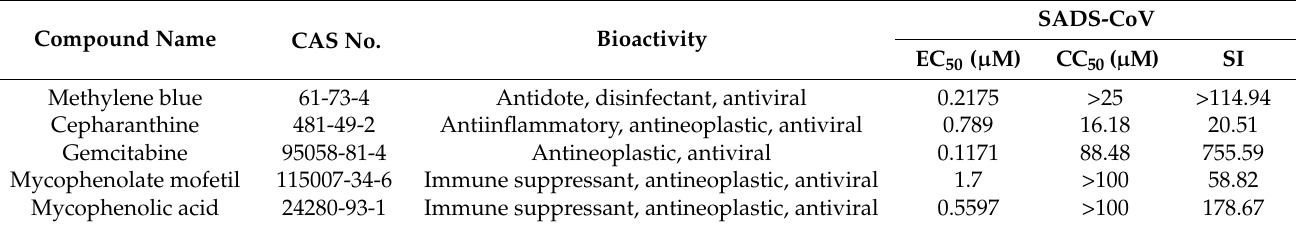
Figure 2. Validations of antiviral drugs selected from primary screening. Two-fold serial dilutions of methylene Blue, cepharanthine, gemcitabine, mycophenolate mofetil, and mycophenolic acid were separately added to the cells for antiviral activity and cytotoxicity test ( A – E ). The positive control was treated with the virus and 0.1% DMSO, while only 0.1% DMSO-containing media were added to the negative control. Cell viability and viral RNA expression levels were separately assayed by CellTiter-Blue and qPCR. Inhibitory rate and cytotoxicity were evaluated, compared with the positive and negative control, respectively. Dose-response curves were generated, and EC 50 and CC 50 values were calculated by using nonlinear regression analysis. Data represent the mean of the three replicate results. Error bars represent ± 1 SD, and the experiments were repeated at least twice. Table 1. The summary of anti-SADS-CoV activity tested in